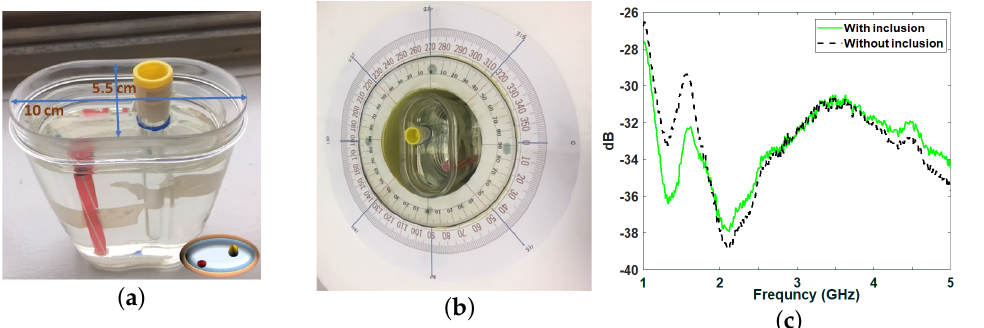
Figure 6. ( a – c ) Depict the fabricated re-miniaturized torso phantom, the position of the torso phantom inside the Mammowave device, the S21 for both the phantom with and without inclusions, calculated when the transmitting antenna is Tx 1 and the receiving antenna is 180 ◦ apart,